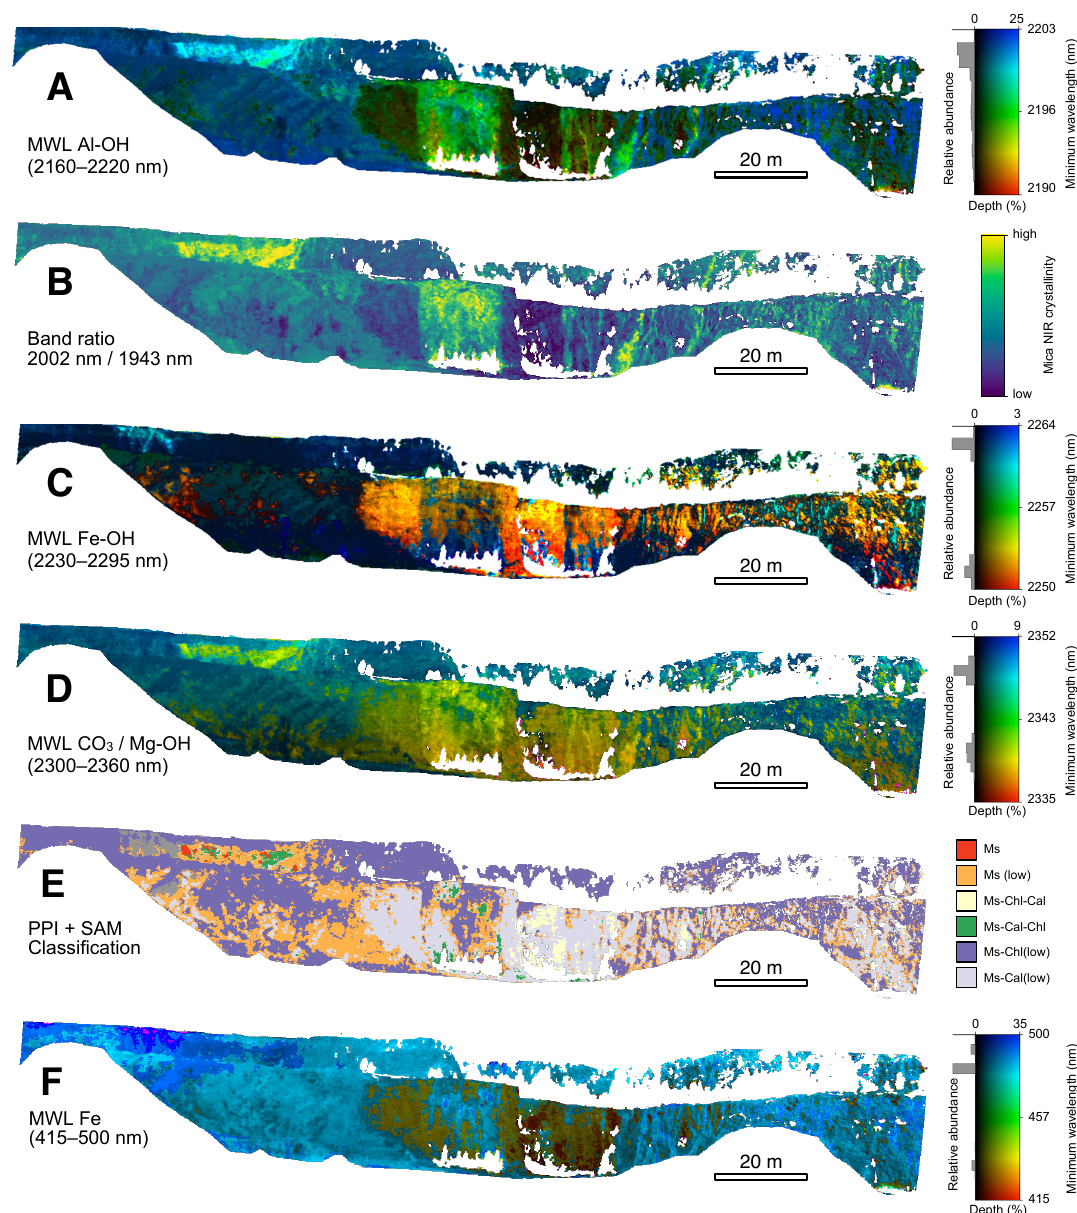
Figure 5. Image processing results for the terrestrial VNIR–SWIR hyperspectral data. ( A )